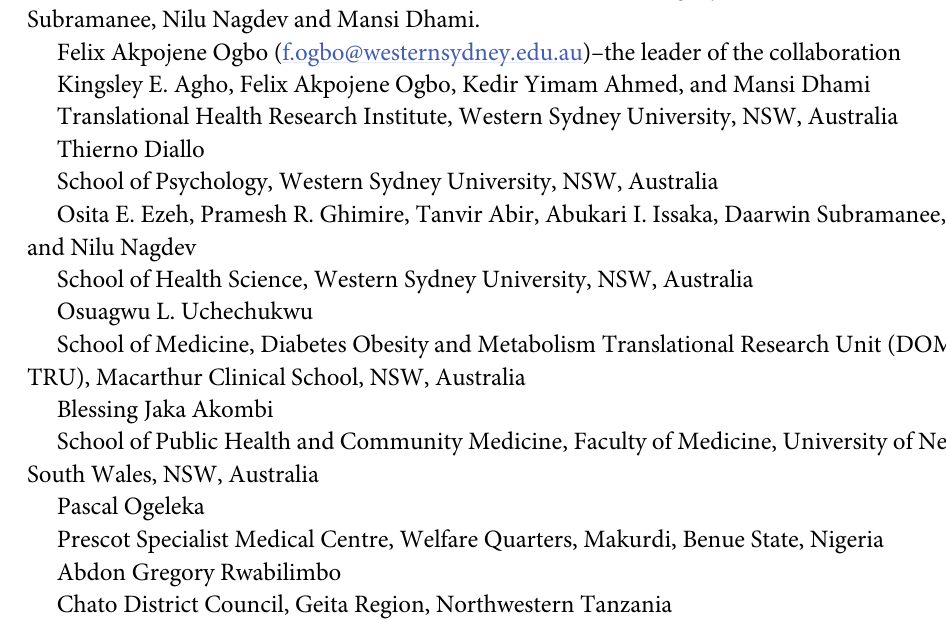
S1 Table. Characteristic of the study participants of reproductive age Tanzanian women, 2015–16. S2 Table. Factors associated underweight, overweight and obesity among reproductive age women in Tanzania,